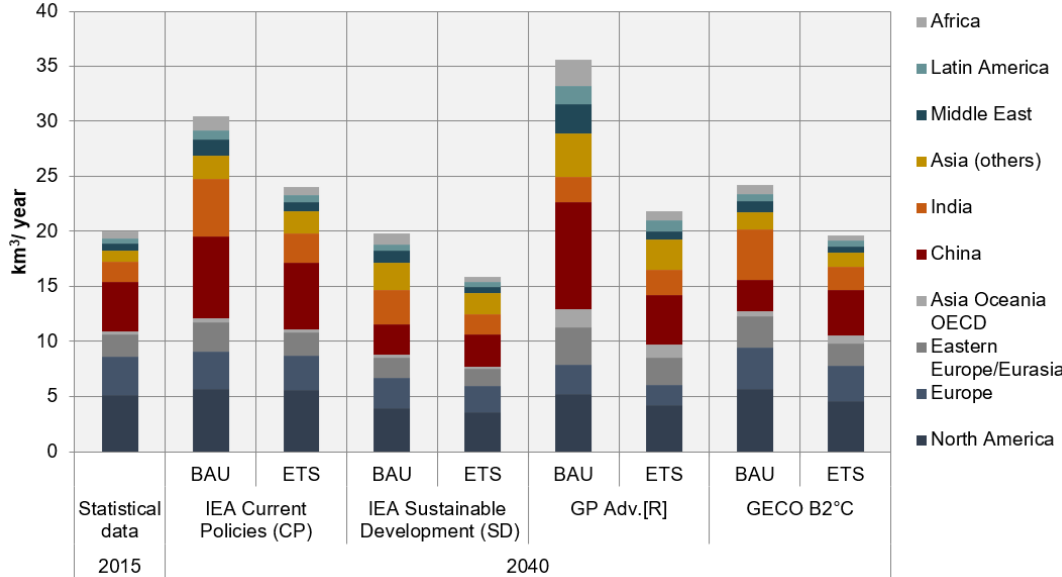
Figure 9. Water consumption for electricity generation (in km 3 per year, excluding hydropower) by region in 2015 and the four energy scenarios in combination with changes in the power plant type and cooling technologies (BAU and ETS scenarios) in 2040. (Source: own calculation based on the data from